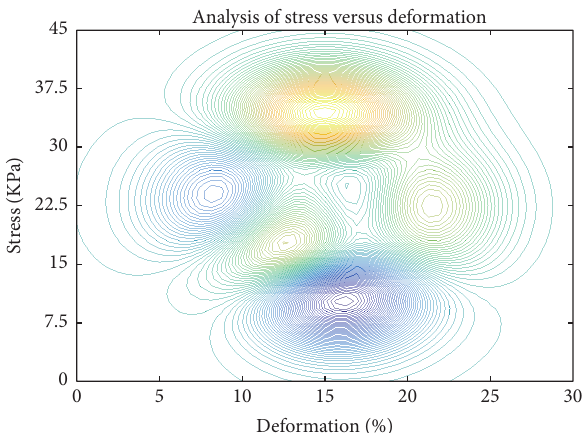
Figure 4: SS 304 stress and deformation correlation analysis in the ten cycles per minute period.